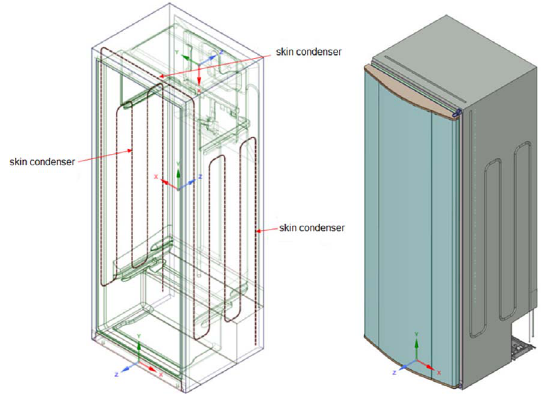
Figure 1. Refrigerator with skin condenser.